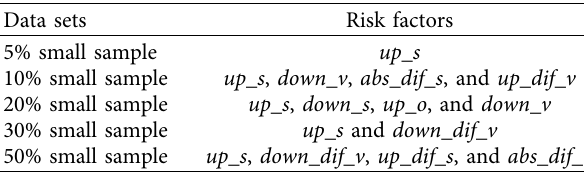
Table 3: Significant variables in small sample data sets. Data sets